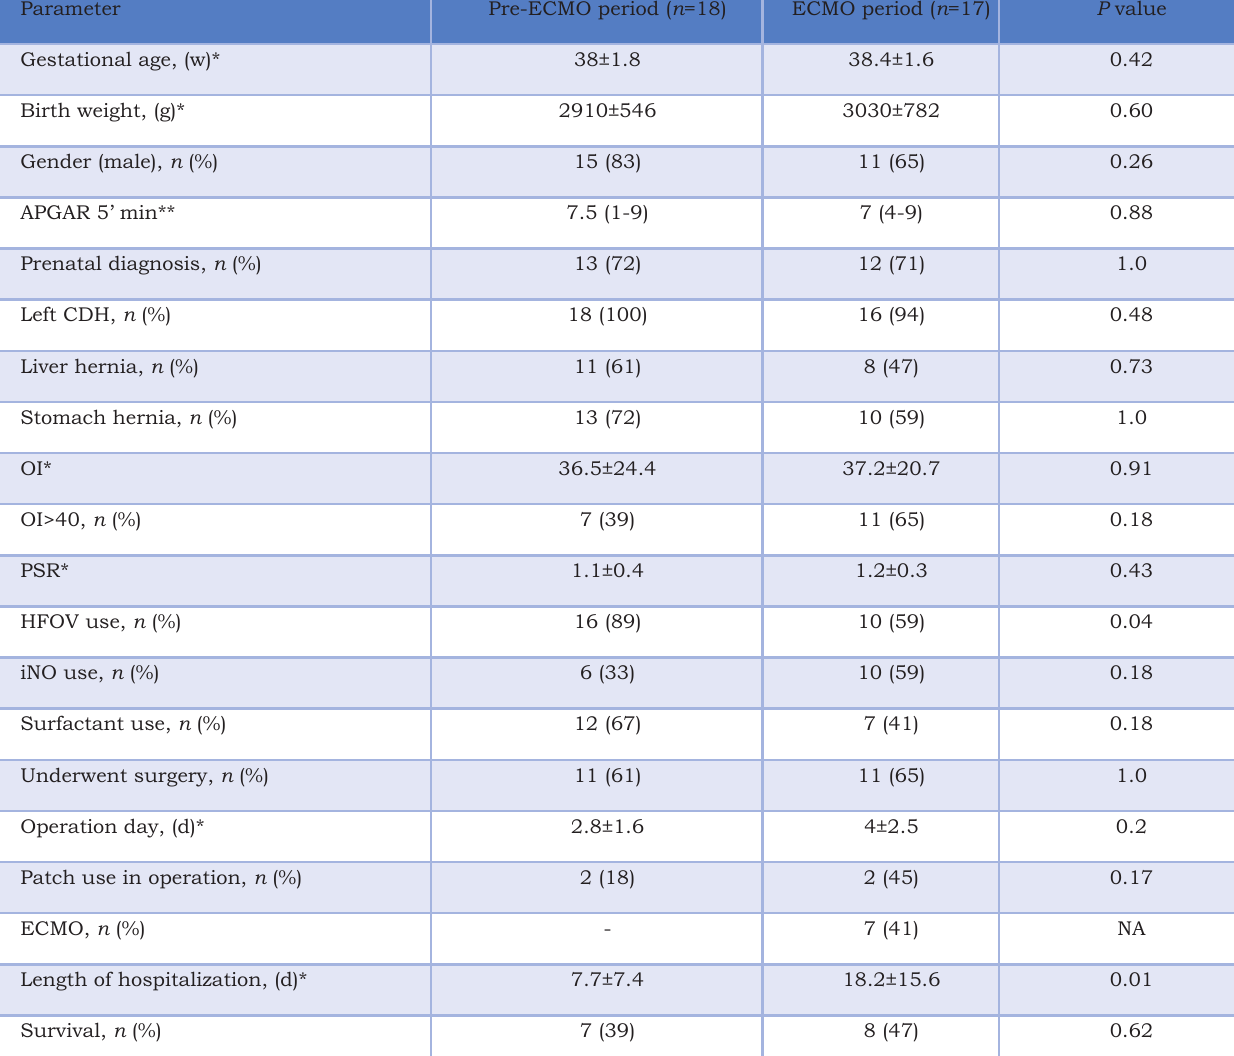
Table 1: The demographic and clinical data of patients in both groups Parameter Pre-ECMO period ( n